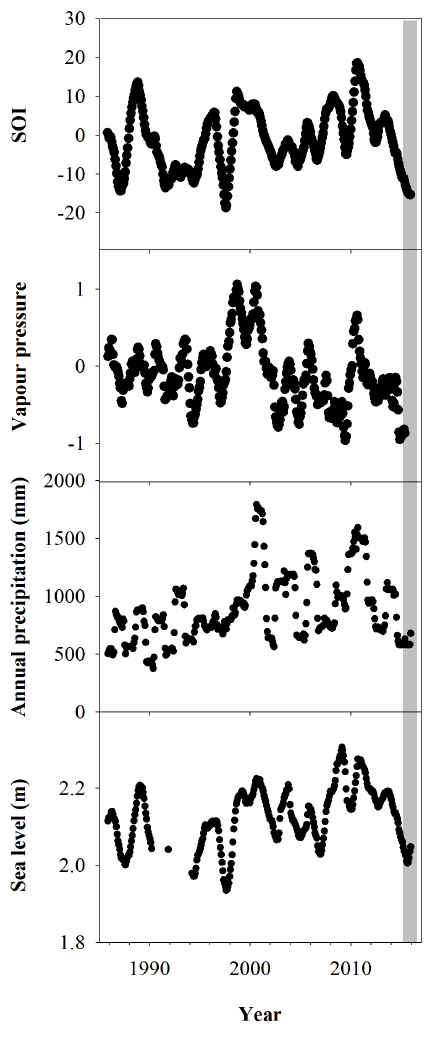
Figure 2. Climate observations from the south-eastern Gulf of Car- pentaria, Australian (Jones et al., 2009; Harris et al., 2017; Bureau of Meteorology, 2019). The grey bar represents the period during which the dieback event